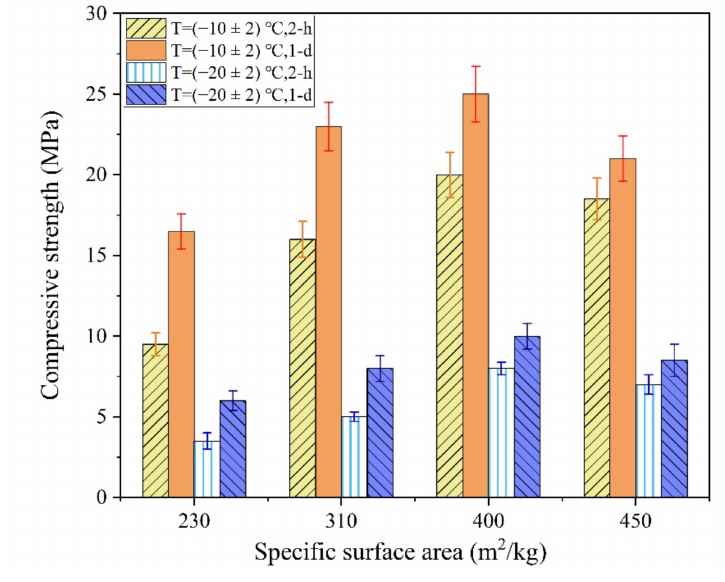
Figure 6. The influences of SSA of M on the early strength of the MPC.